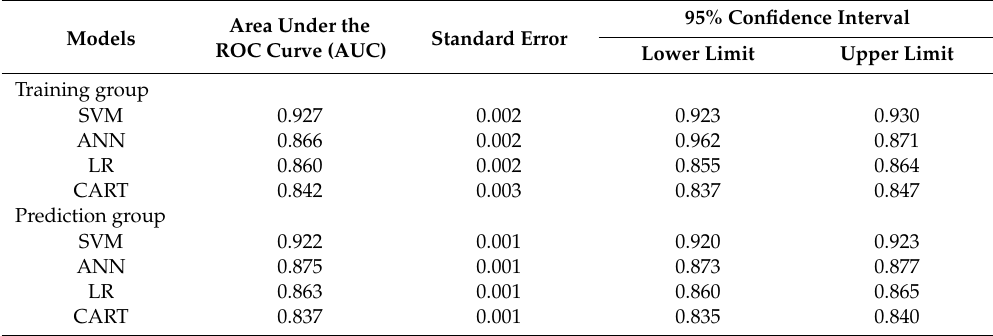
Table 8. The prediction performance comparison.